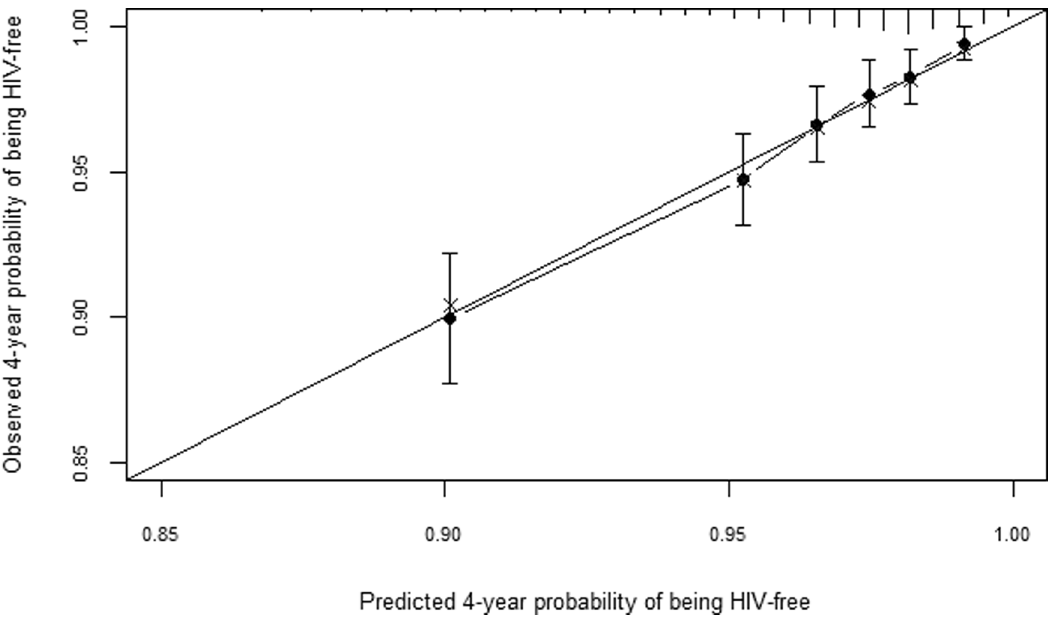
doi:10.1371/journal.pone.0092015.g003